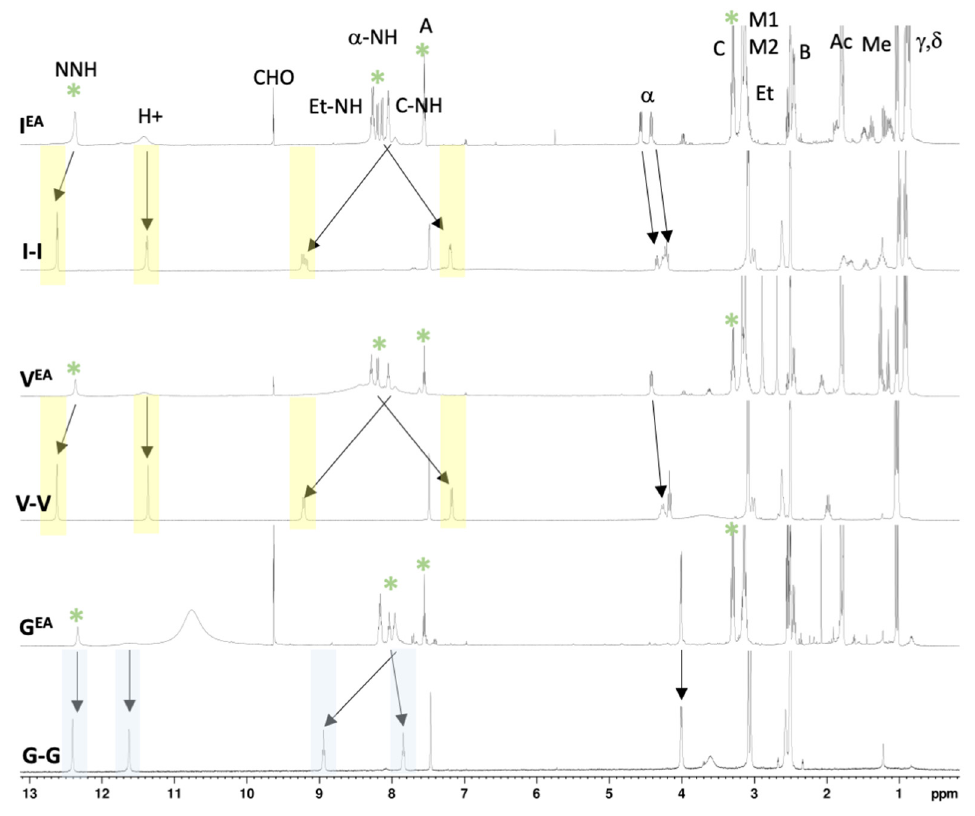
Figure 2. The 400 MHz 1 H NMR spectra of macrocycles and acyclic models. Two subpopulations are indicated with yellow ( V-V and both isomers of I-I ) and blue boxes ( G-G ). Arrows indicate a common change in chemical shift between the macrocycle and its corresponding acyclic model. Elements shared across the acyclic intermediates are indicated with a green asterisk. See text for additional detail.